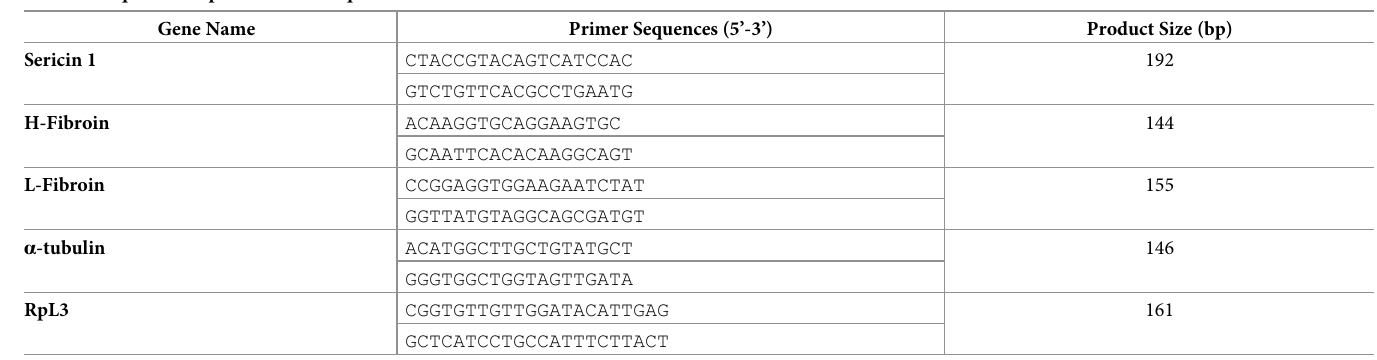
Table 1. Sequences of primers used in